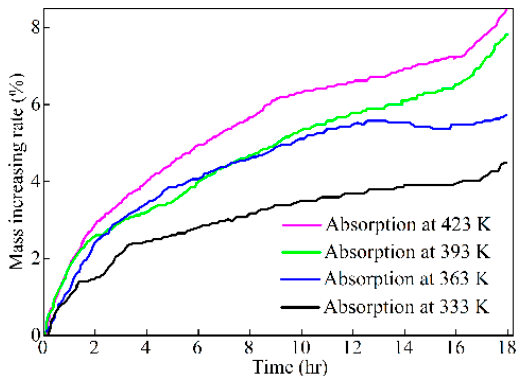
Figure 7. Weight percentage of synthetic LiBO 2 at 333–423 K.